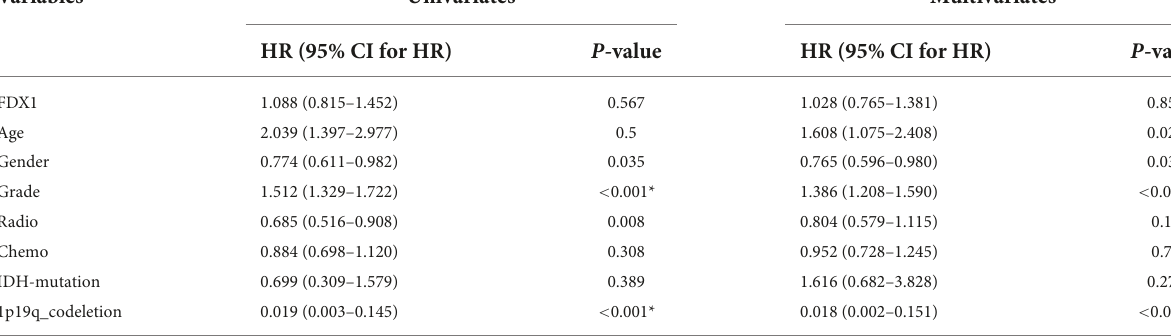
TABLE 2 Cox regression analysis of the clinical variables, and overall survival in TCGA